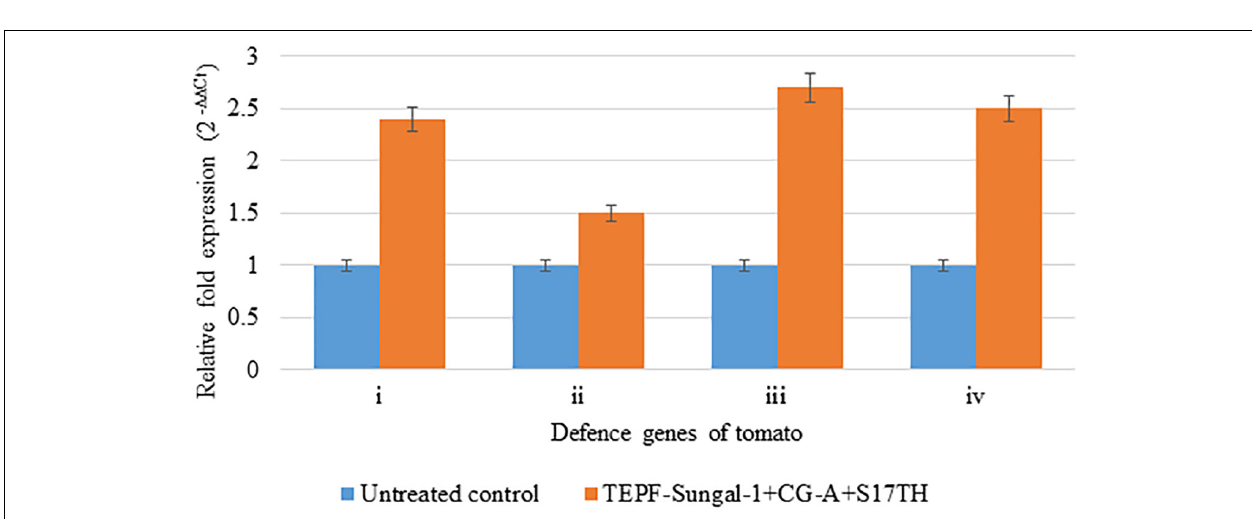
FIGURE 7 | Relative expression of defense genes in the tomato plants cv. Pusa Rohini induced by the potential biocontrol treatment. TEPF-Sungal-1 (Pseudomonas putida) + CG-A (Chaetomium globosum) + S17TH (Trichoderma harzianum) challenge inoculated with the Fusarium oxysporum f. sp. lycopersici strain, TOFU-IHBT over the untreated control, (i) vzrJ [endochitinase]; (ii) g6pd [glucosamine-6-phosphate (Gln-6P) deaminase]; (iii) PGK [phosphoglycerate kinase]; (iv) XDUS8 [NADH dehydrogenase [ubiquinone] iron-sulfur protein 8]. The amount of cDNA in the sample were normalized employing actin as an internal control. Error bars indicate Standard Deviation